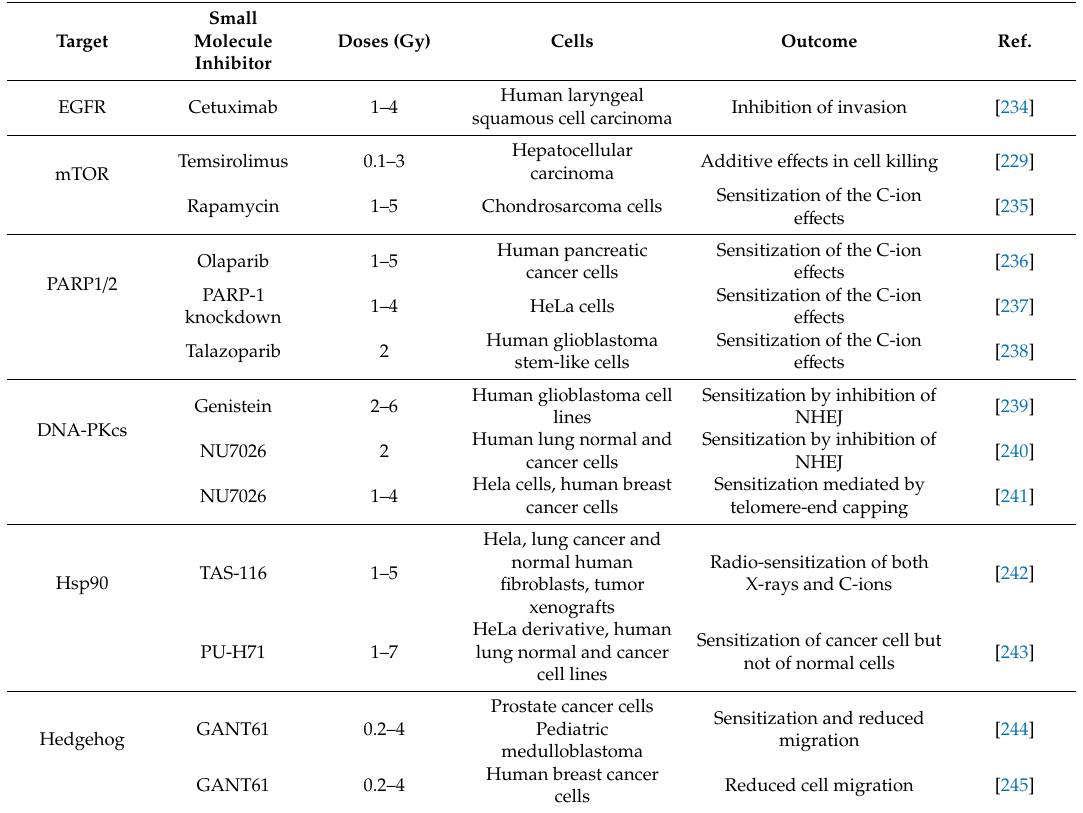
Table 3. C-ions and targeted therapy combination